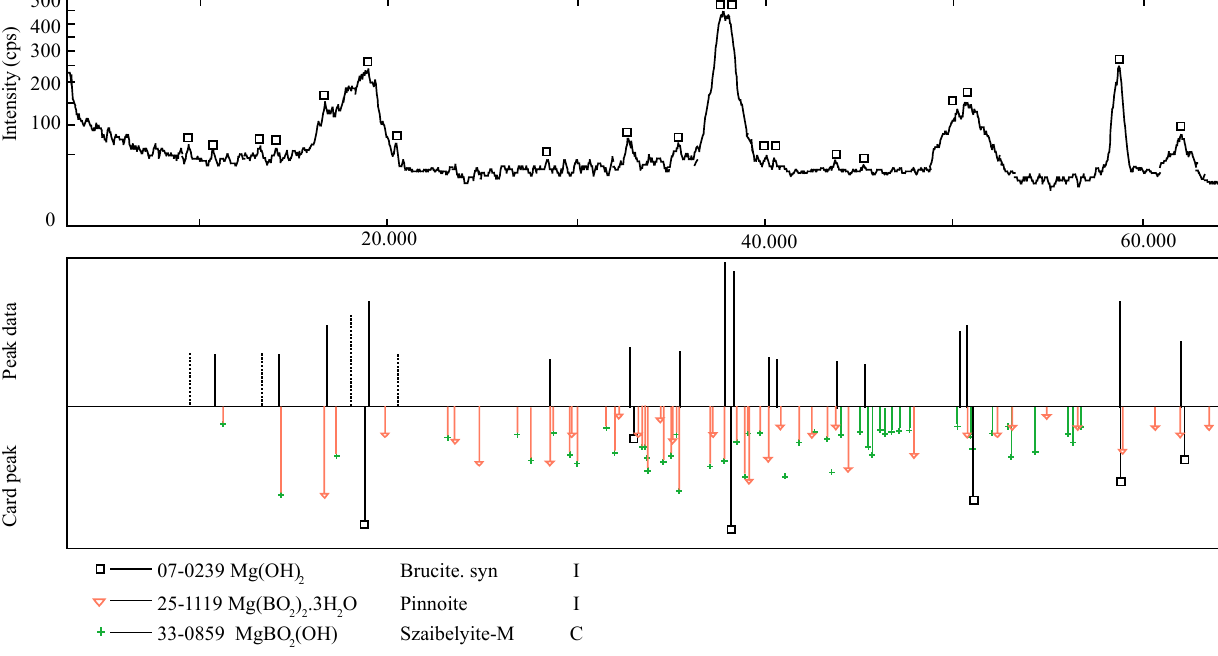
Fig. 8. X-Ray diffractogram of brucite deposited from B-containing artificial seawater at pH 9.5. It is a magnified figure of Fig. 7c. Compared with Fig. 7b, the brucite peak in Fig. 8 is clear, with apparent peaks of pinnoite (Mg(BO 2 ) 2 · 3H 2 O) and szaibelyite (MgBO 2 (OH)). Judging from the quantity and intensity of these peaks, pinnoite content should be higher than that of szaibelyite. As the pH increases, the borate peak gradually weakens (Fig. 7c–h). When the pH is 12.5 (Fig. 7h), its peak is very close to that of Mg(OH) 2 standard (Fig. 7a), although the characteristic pinnoite peak is still